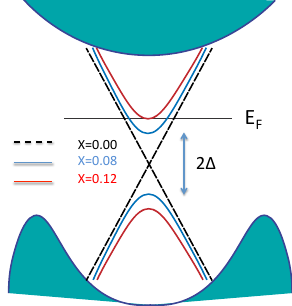
Figure 1 . Evolution of density of state. As we increase the doping and thereby the surface gap of the TI, the fermi surface gets